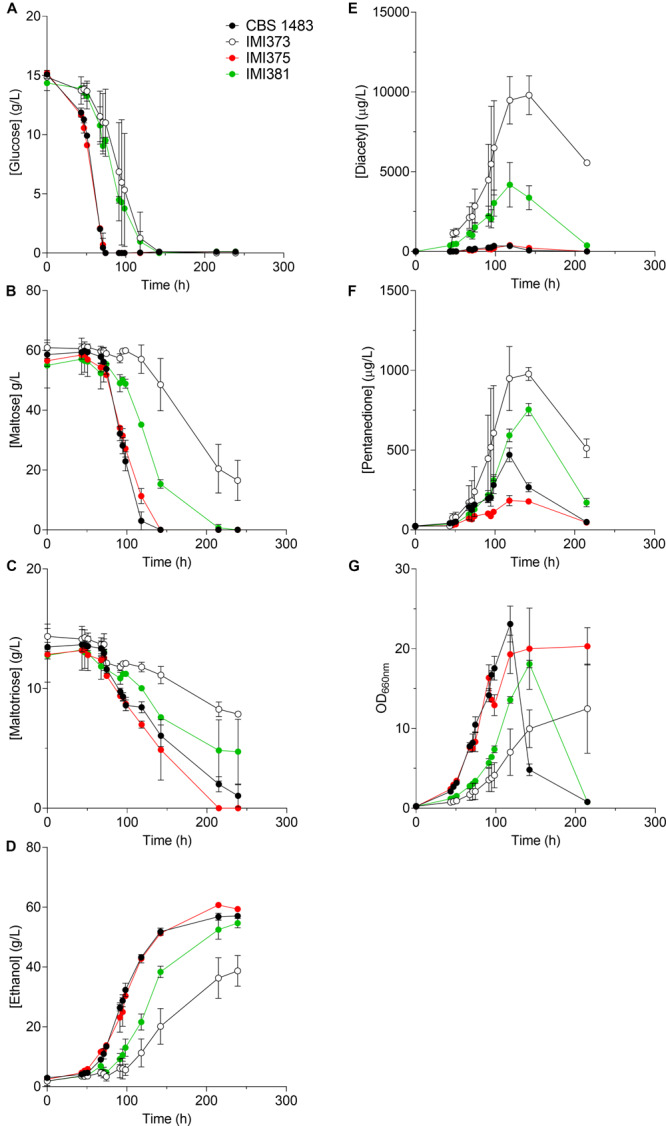
Characterisation of CBS 1483, and IMI373, IMI375 and IMI381 under brewing conditions. The S. pastorianus strains CBS 1483 (black circle), IMI373 (ScCHRX-SeCHRX–1 SeCHRIX–1) (white circle), IMI375 (ScCHRII–1
ScCHRV–1
ScCHRVIII–3
ScCHRXIII–1 ScCHRXIV–1 SeCHRI–1
SeCHRIII-ScCHRIII–1
SeCHRVII-ScCHRVII–1
SeCHRVIII-XV+1) (red circle) and IMI381 (ScCHRIV+1
ScCHRVIII–1
ScCHRIX+1
ScCHRXI–1
ScCHRXII–1
SeCHRX-SeCHRX–1
SeCHRII-IV–1
SeCHRXI+1) (green circle) were grown in air-capped 100 ml serum bottles in undiluted industrial wort at 12 °C. Average and standard deviation from duplicates (IMI373 and IMI375) or triplicates (IMI381 and CBS 1483) are shown. (A) displays glucose, (B) maltose, (C) maltotriose, (D) ethanol determined by liquid chromatography; (E) diacetyl, (F) pentanedione concentrations produced in industrial wort measured using static headspace gas chromatography and (G) optical density measured at 660 nm (OD660 is directly related with biomass concentration in suspension).